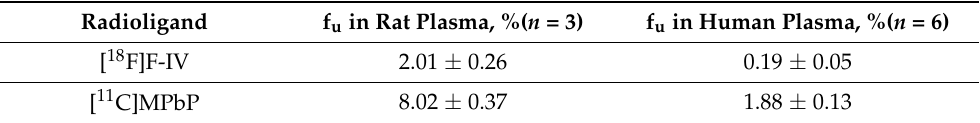
Table 2. Measured unbound (free) fraction (f u , %) data for [ 18 F]F-IV and [ 11 C]MPbP.